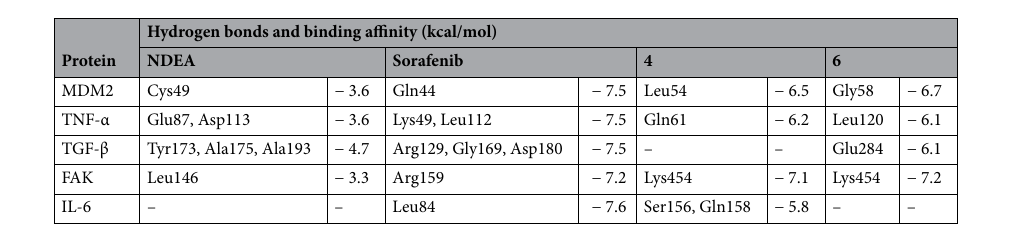
Figure 4. Effect of compounds 4 and 6 on histopathological properties of (NDEA + PB)-induced hepatocellular carcinoma in Sprague–Dawley rats at 100x. ( a ): Normal control; ( b ) Disease control (NDEA + PB); ( c ) Standard control (NDEA + PB + Sorafenib); and four tested groups: ( d ) NDEA + PB + 4 -LD; ( e ) NDEA + PB + 4 -HD; ( f ) NDEA + PB + 6 -LD; ( g ) NDEA + PB + 6 -HD. NDEA: N -nitrosodiethylamine (200 mg/kg); PB: phenobarbital sodium (500 parts per million). Sorafenib: 30 mg/kg; 4-/6- LD: 5 mg/kg; 4-/6- HD: 10 mg/kg. Yellow right arrow: Healthy hepatocytes; Blue isosceles triangle: central vein; Red teardrop: fibrosis and cytoplasmic fat infiltration; Red pentagon: regeneration of necrotic hepatocytes; Red chevron: tumor nodules.